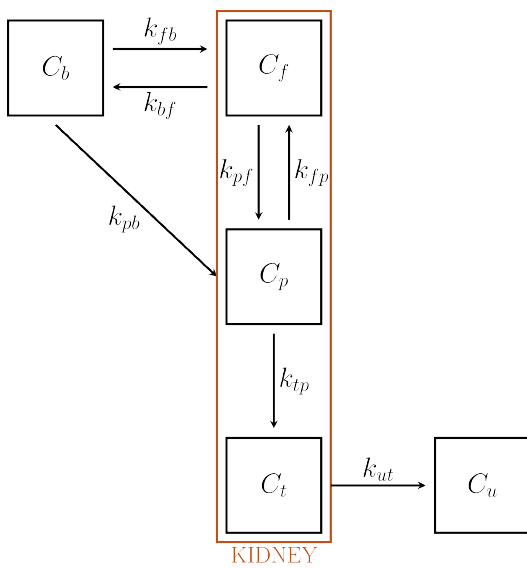
Figure 7. Compartment model for the renal